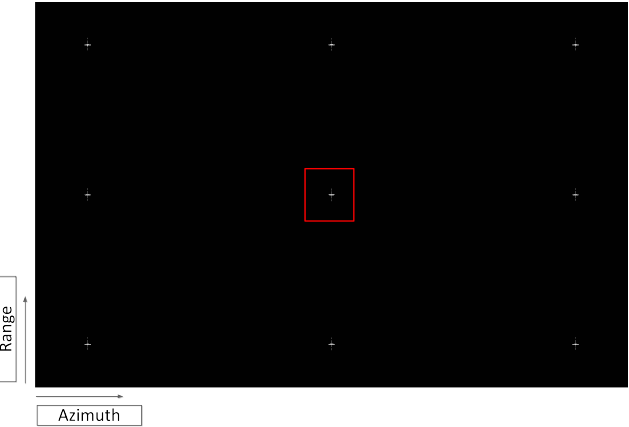
Figure 10. The point array target used in simulation.